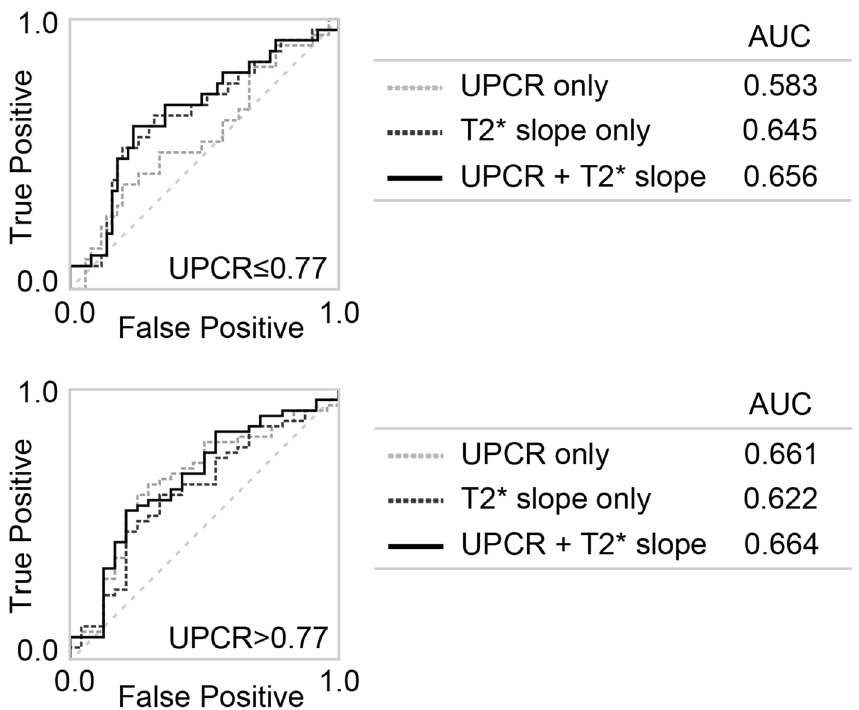
Figure 2. Receiver operating characteristic curve for CKD progression/eGFR decline. Cases were divided into two groups according to degree of proteinuria. UPCR urinary protein/creatinine ratio, AUC area under the curve.